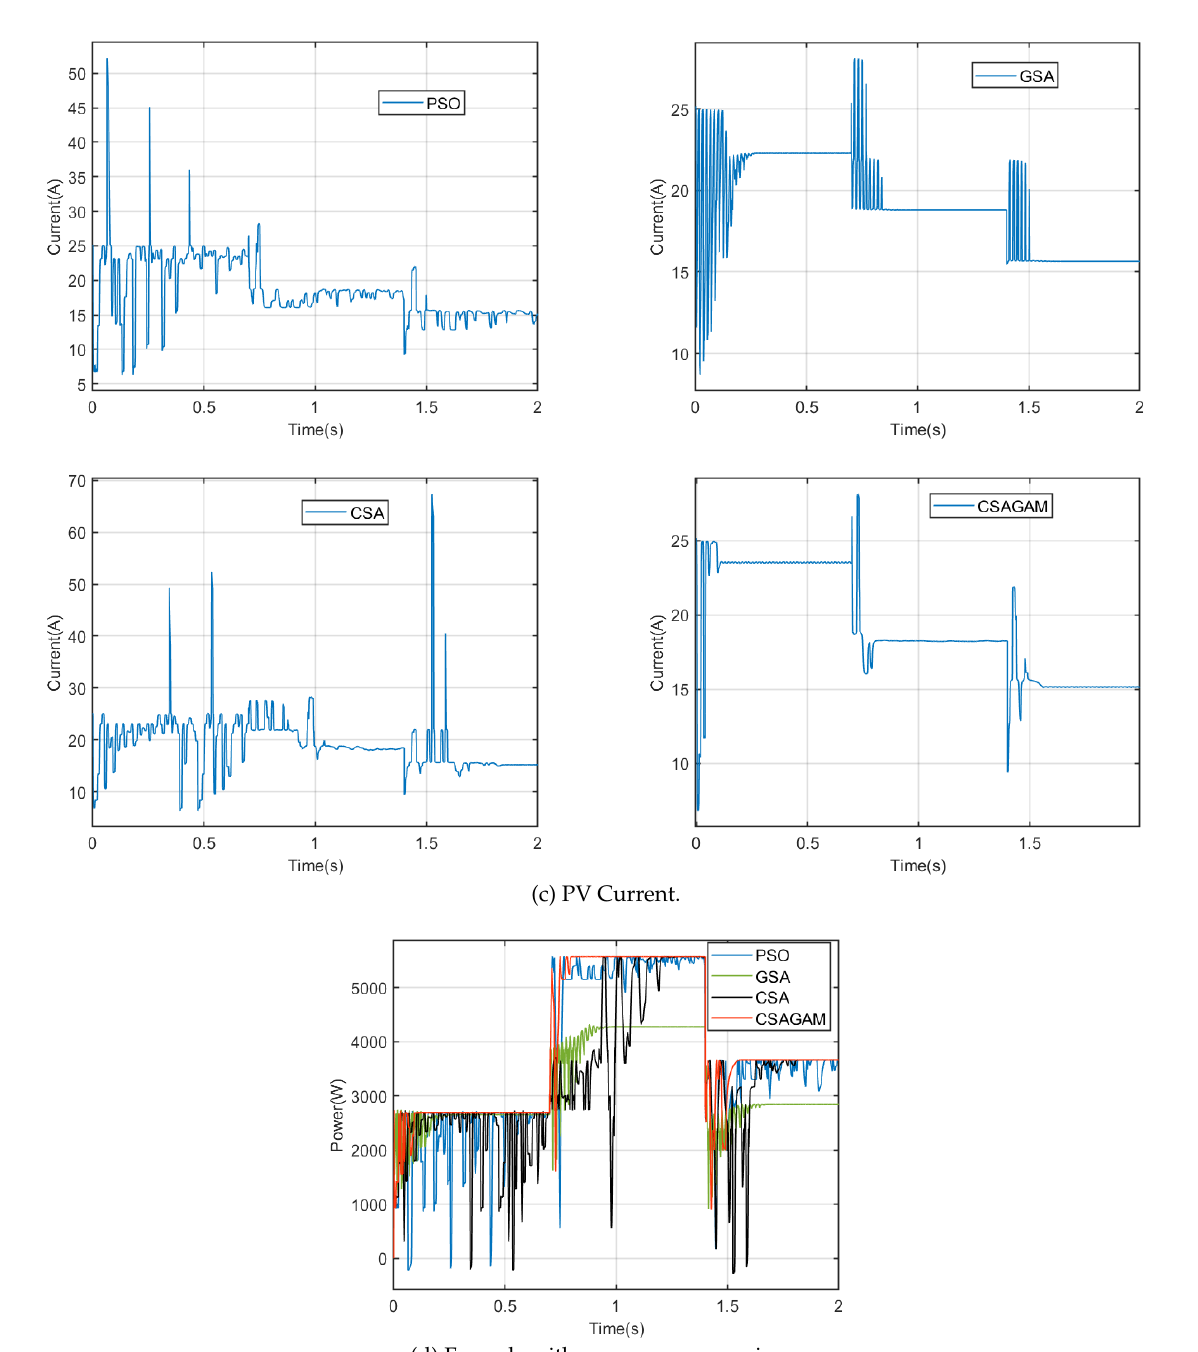
Fig. 10. Simulation results for the changing partial shading PSC 3-PSC 1-PSC 2.